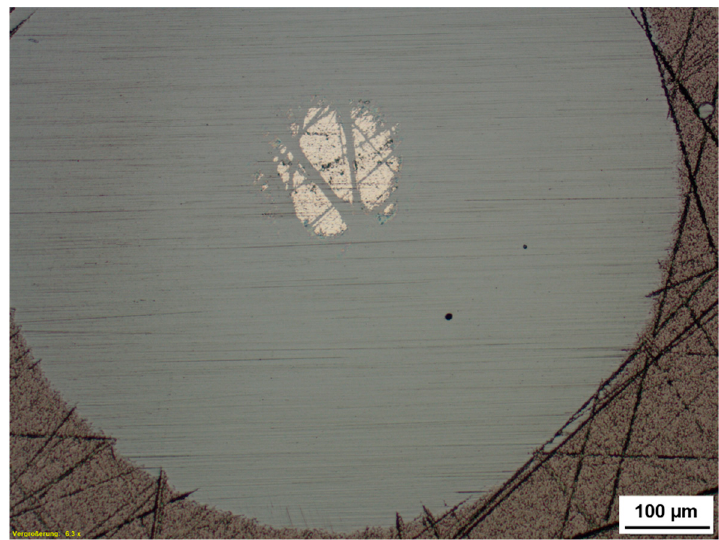
Figure 1. Calotte section of the Ti 1 − x Al x N coating on WC-Co substrate.